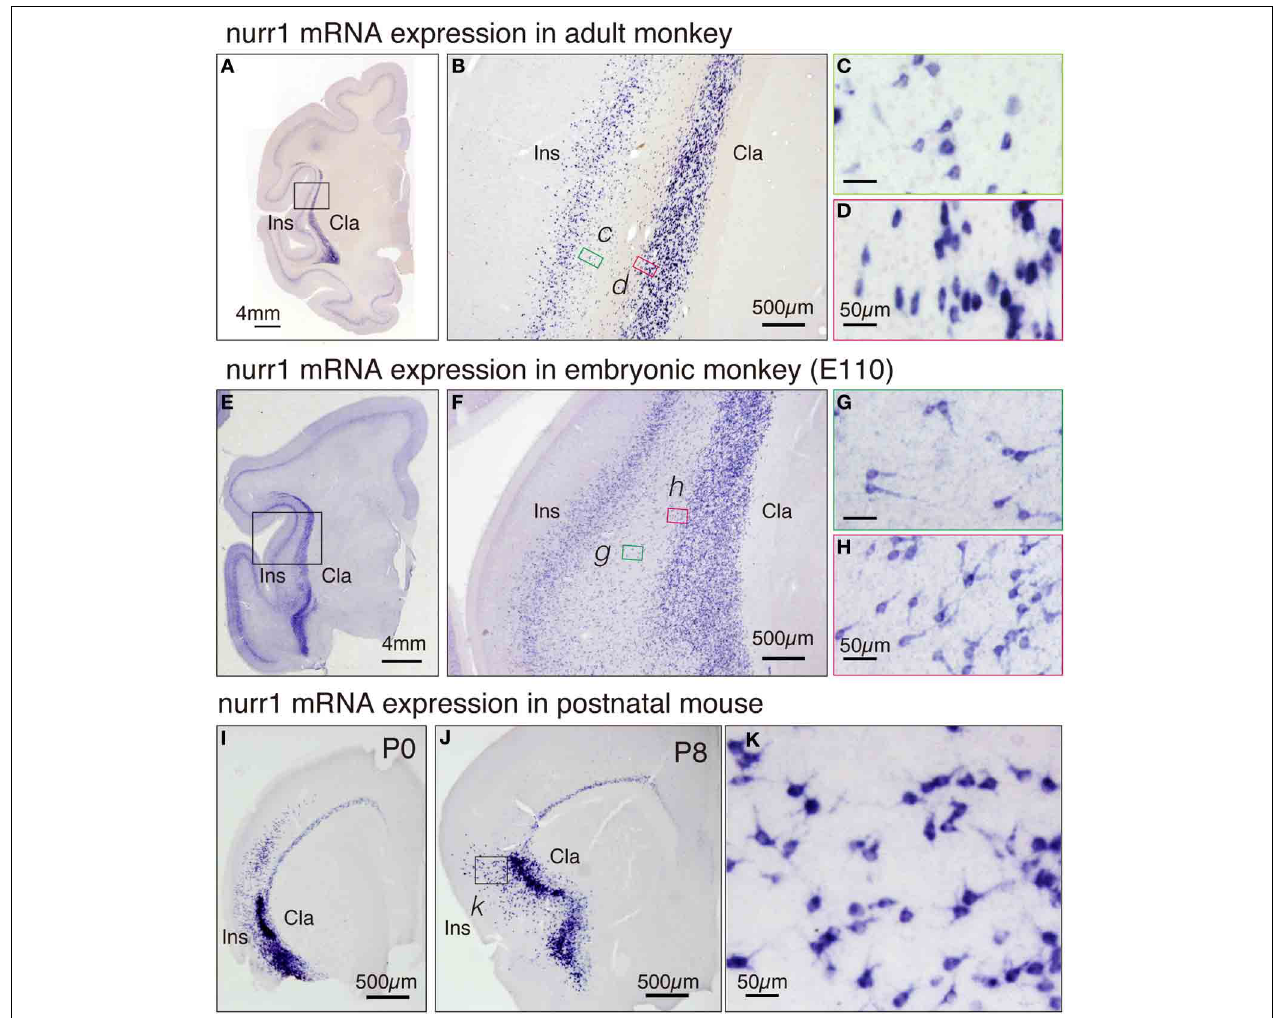
FIGURE 6 | Expression of nurr1 mRNA in the embryonic monkey and postnatal mice. (A) Single ISH of nurr1 mRNA in the coronal section of the adult monkey brain hemisphere. Note a dense expression of nurr1 mRNA in the claustrum and layer 6 of the insular cortex. (B) The rectangle in (A) was magnified. Note the scattered cell population in the white matter between the insular cortex and the claustrum. (C,D) The rectangles in (B) were magnified. (C) shows the shapes of the cell bodies at the bottom of the insular cortex, most of which were typical pyramidal except those at the very bottom (right side of the panel). (D) shows the shapes of the cell bodies at the top of the claustrum, which are elongated in horizontal direction. (E) ISH